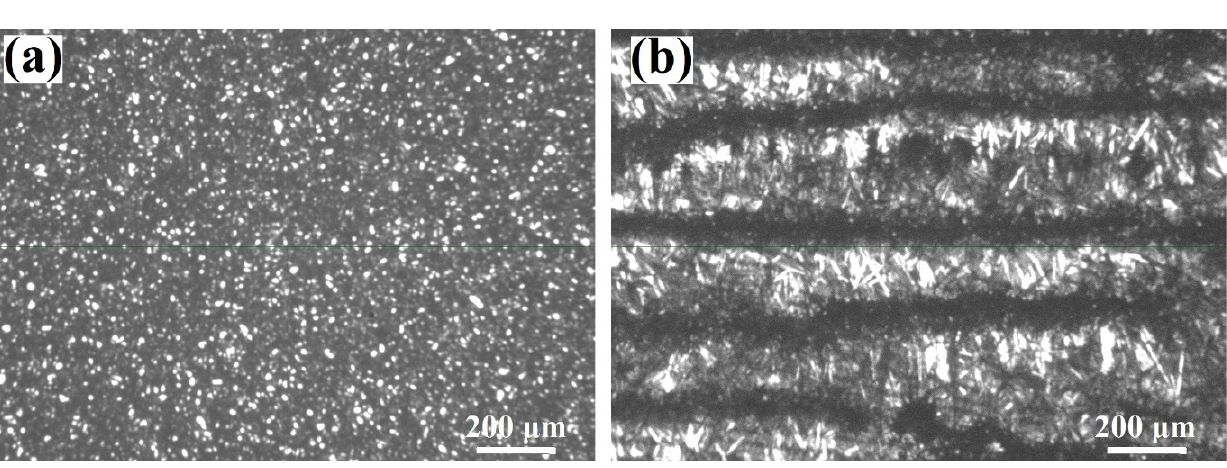
Figure 2. Top-view optical microscopic images of the perovskite films fabricated using the ( a ) spin-coating and ( b ) inkjet- printing techniques.